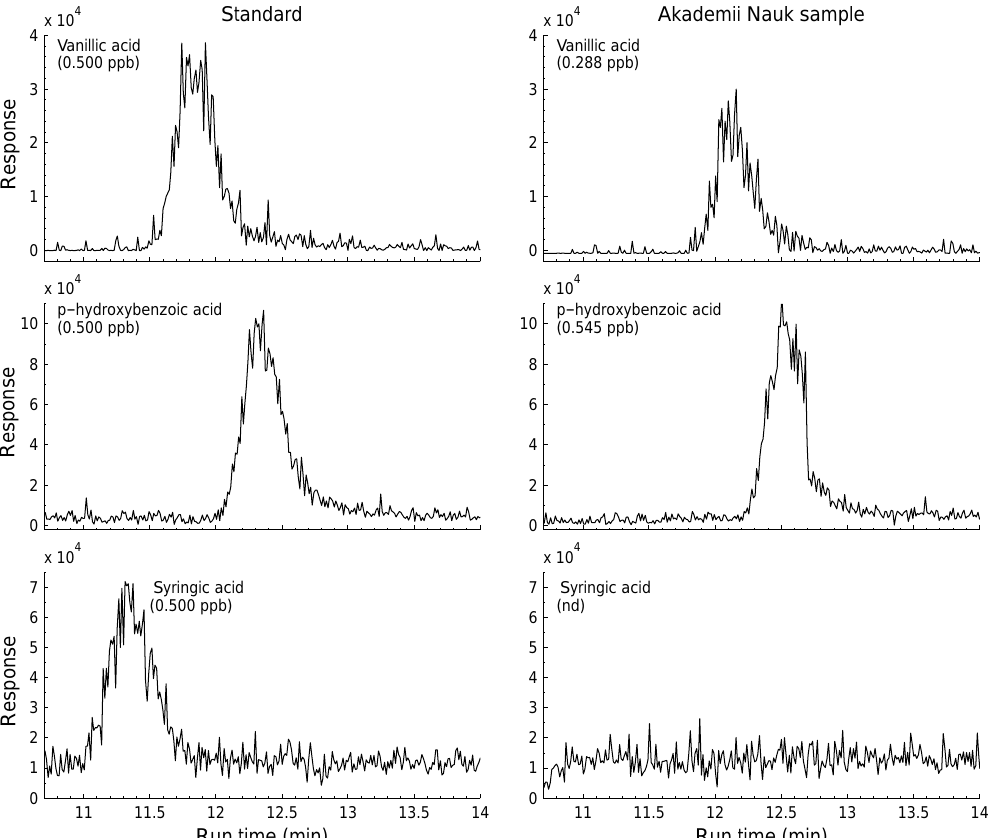
Figure 2. Analysis of vanillic acid, para -hydroxybenzoic acid, and syringic acid using ion chromatography with electrospray ionization and tandem mass spectrometry. Left: standards; right: Akademii Nauk ice core sample (219m, 1450CE) containing 0.288ppb vanillic acid and 0.545ppb para -hydroxybenzoic acid. Syringic acid was not detected in the